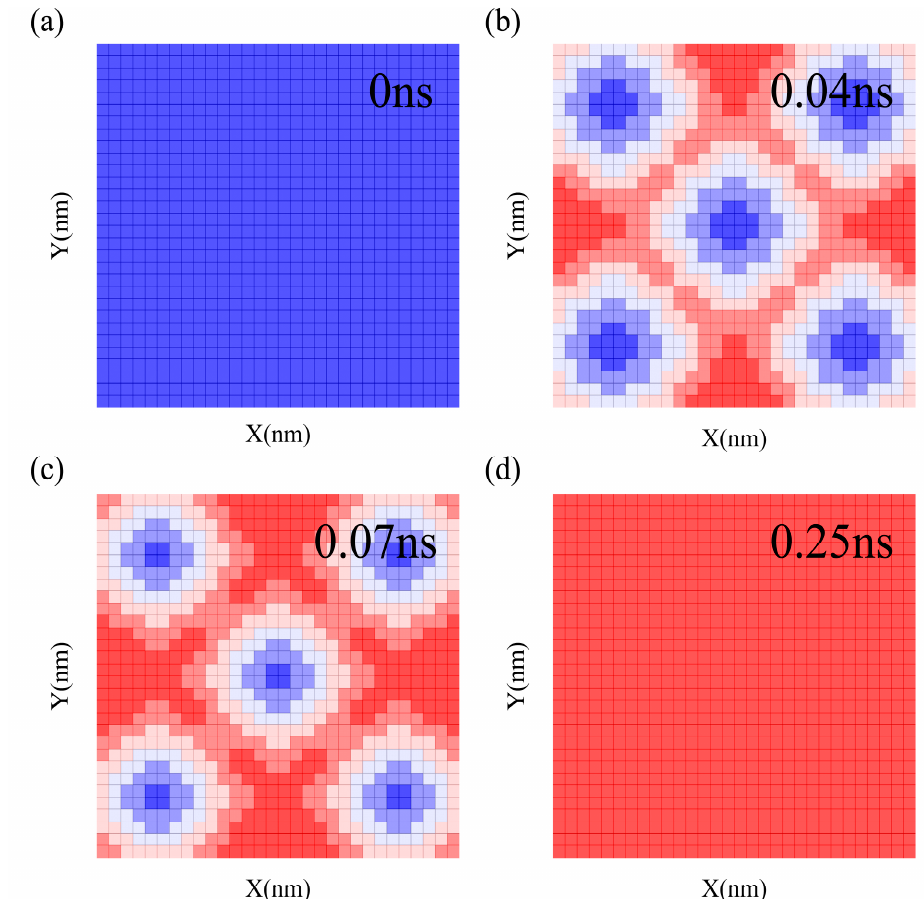
Figure 7. ( a ) The initial 0 ns temperature of the layer of silicon at around 300 K; ( b ) and ( c ) show the temperature distribution of the process in 0.38–0.42 ns and 0.68–0.72 ns; and ( d ) shows the final 0.25 ns temperature of around 350 K.